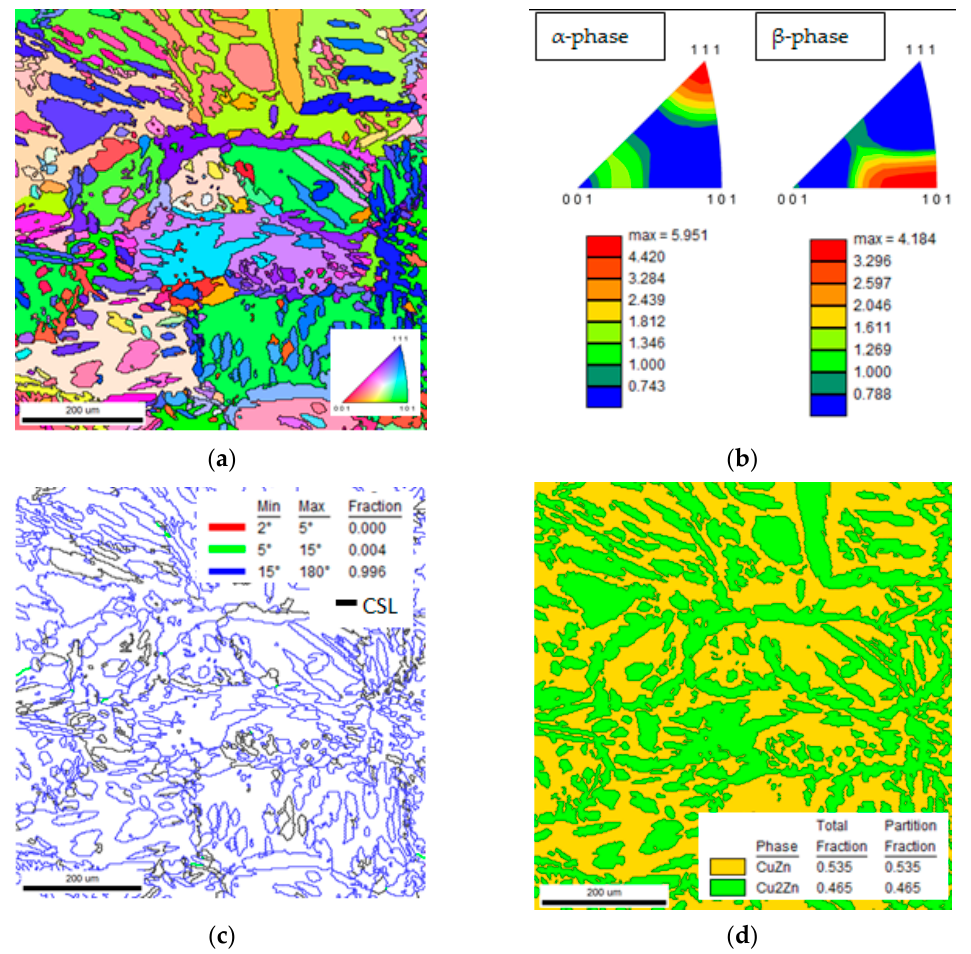
Figure 3. CuZn42 alloy in the as-drawn condition. ( a ) Inverse pole figure (IPF-Z) map and ( b ) texture plots. ( c ) Misorientation and ( d ) phase maps. The α -phase is precipitated in various morphologies from the β -grains. Note: CuZn ( β -phase), Cu2Zn ( α -phase). Unit: µ